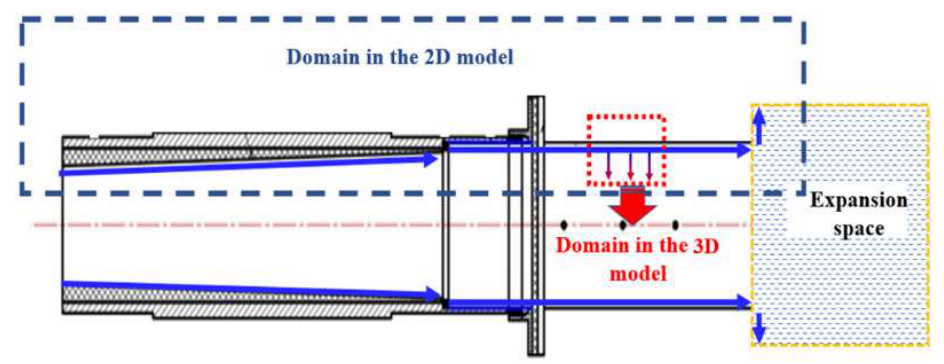
Figure 2. Here the tapered section of the pipe provides a centrifugal force acting on the liquid film to maintain an axial flow. An expansion space is introduced at the end of the rotating pipe to simulate the phenomenon of the rotating liquid film as flowing out of the rotating pipe. Since the 3-D flow field is consistent in the circumferential direction, the 3-D model in circumferential direction is selected as a 1/30 periodic segment. A part of the flow field is intercepted along the axial direction and the partial 3-D flow field is set by the liquid film thickness and pressure gradient obtained from 2-D numerical simulation.